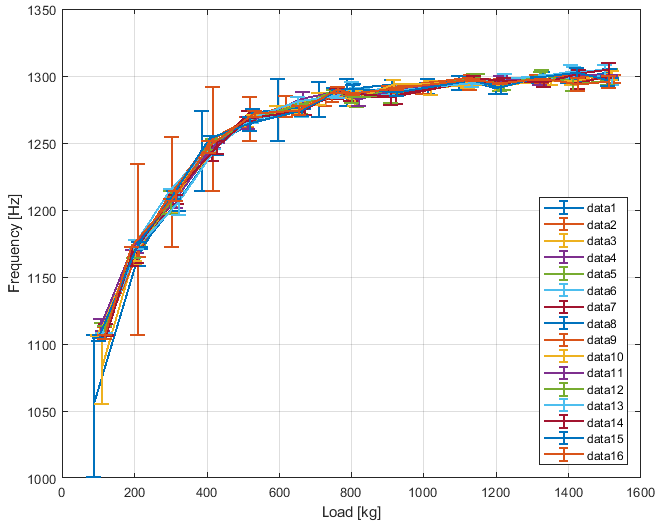
Figure 9. Dependence of the resonance frequency in the function of load for sintered sample determined with the use of acoustic